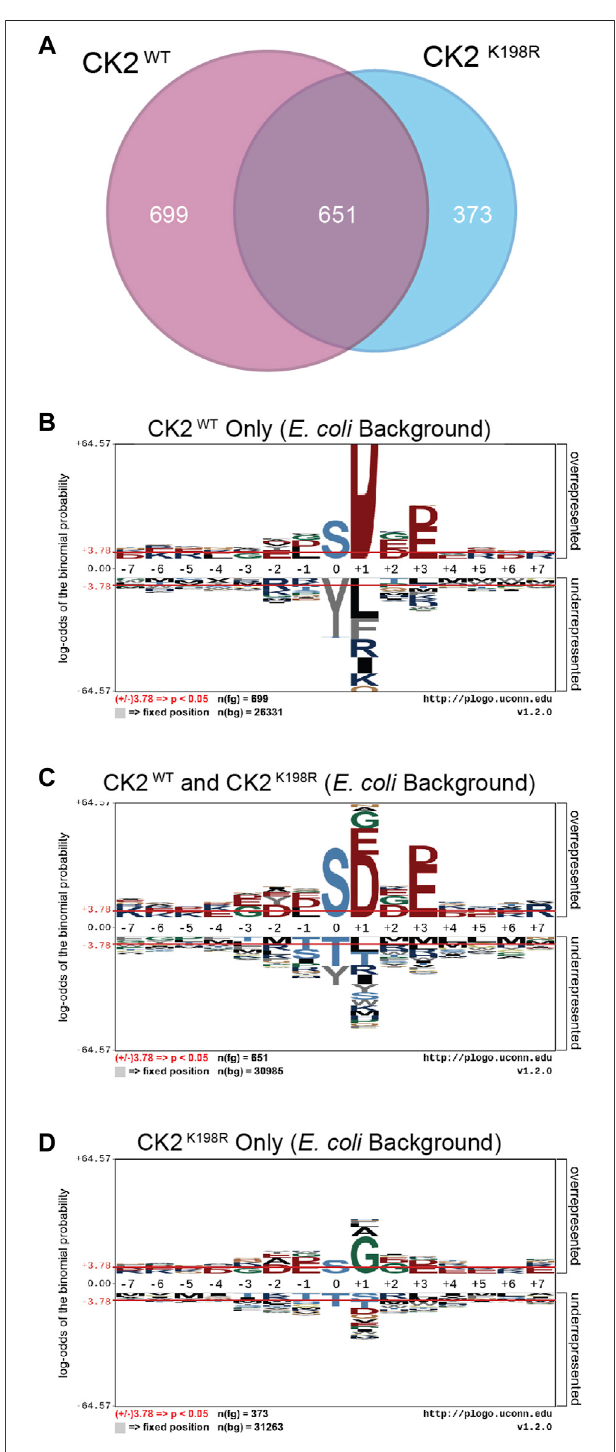
FIGURE 3 | CK2 K198R phosphorylates an expanded complement of substrates . Venn diagram representing the overlap of phosphorylation sites identi fi ed in CK2 WT and CK2 K198R ProPeL experiments (A) . Motifs of phosphopeptides identi fi ed only in CK2 WT (B) , both CK2 WT and CK2 K198R (C) or only in CK2 K198R (D) ProPeL experiments. Phosphopeptides identi fi ed in both CK2 WT and CK2 K198R experiments tend to re fl ect the